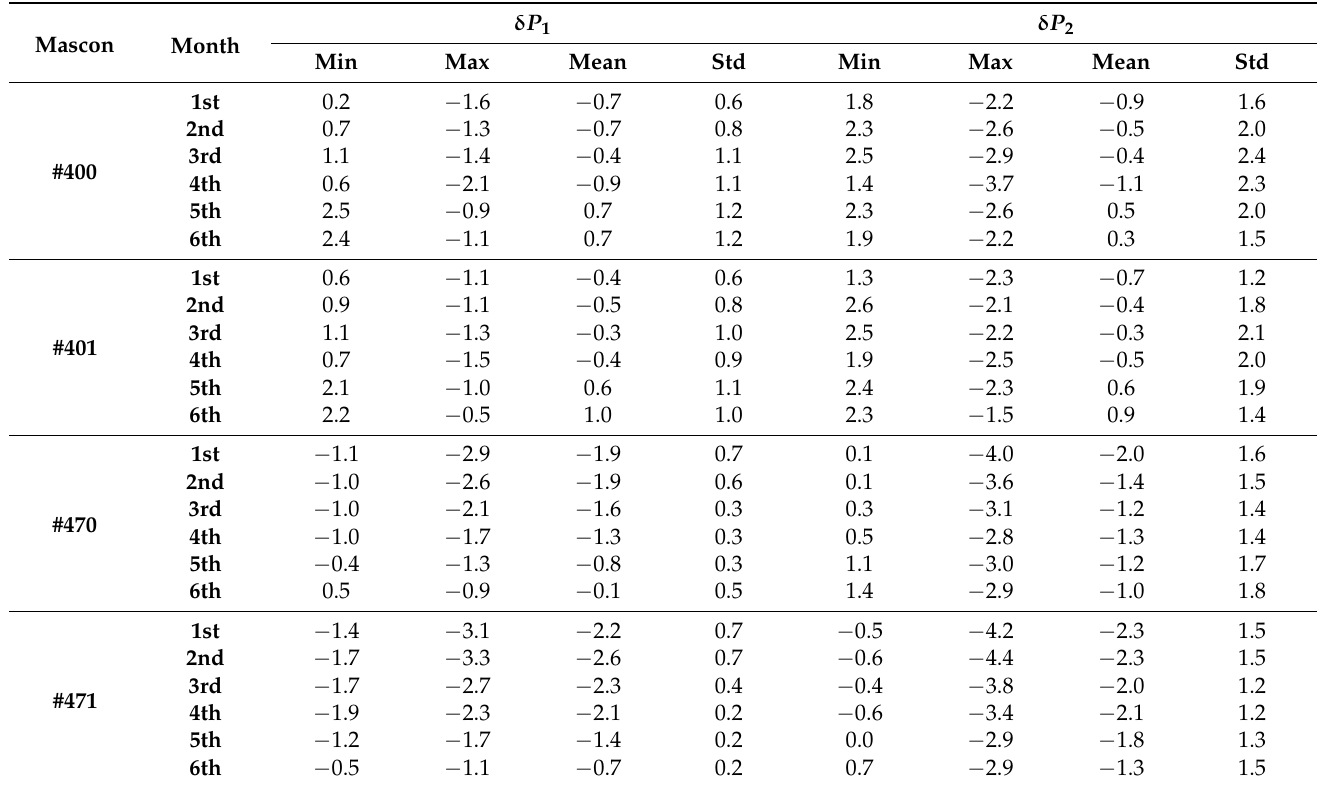
Table 1. Statistics of differences δ P 1 between ∆ H P / ∆ H * P and ∆ H M / ∆ H * M as well as differences δ P